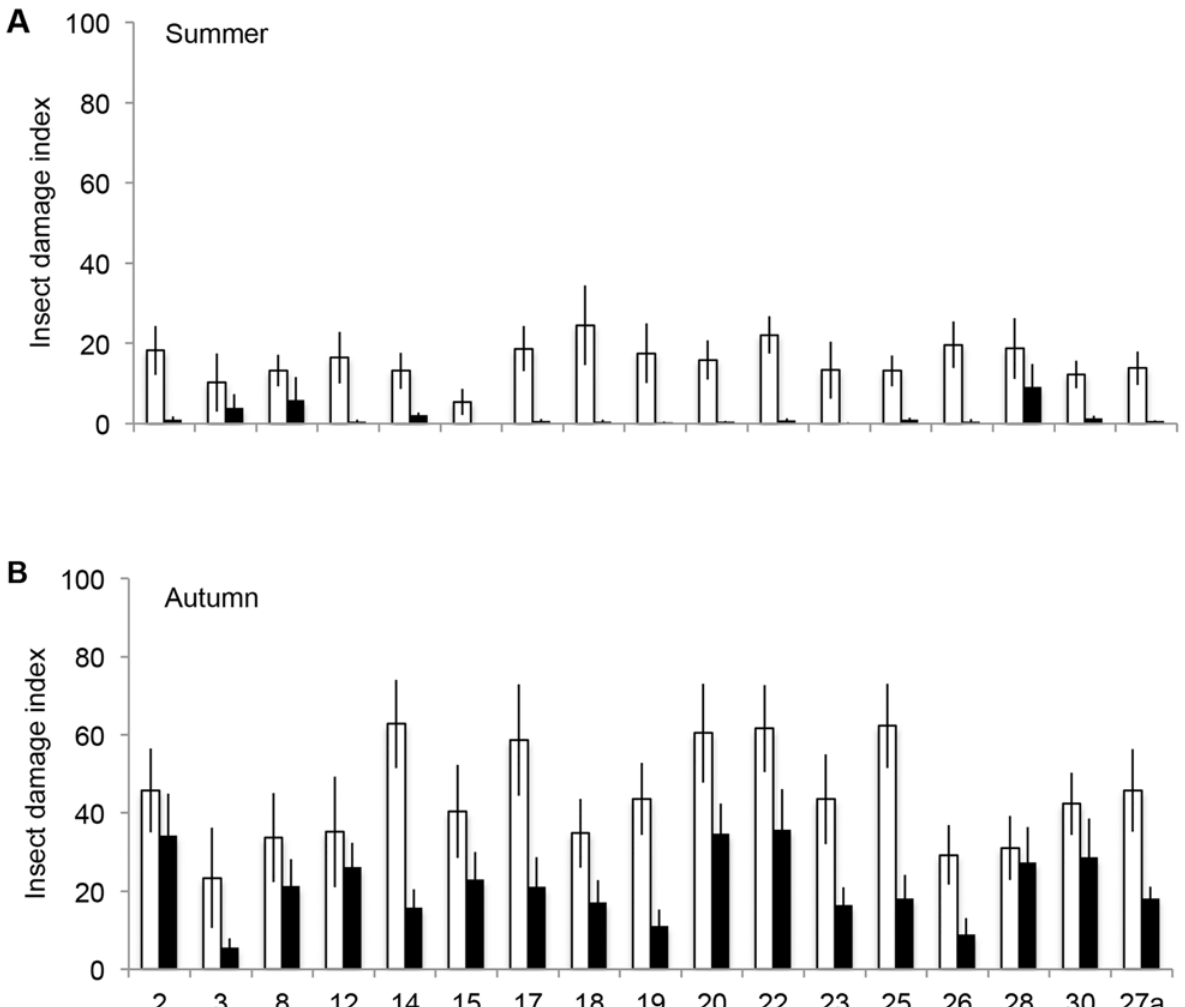
Figure 1. Summer and autumn leaf damage indices of the insecticide treated (black bars) and control (white bars) saplings of 17 B. pendula genotypes (mean ± SE, n = 5 – 6 for each